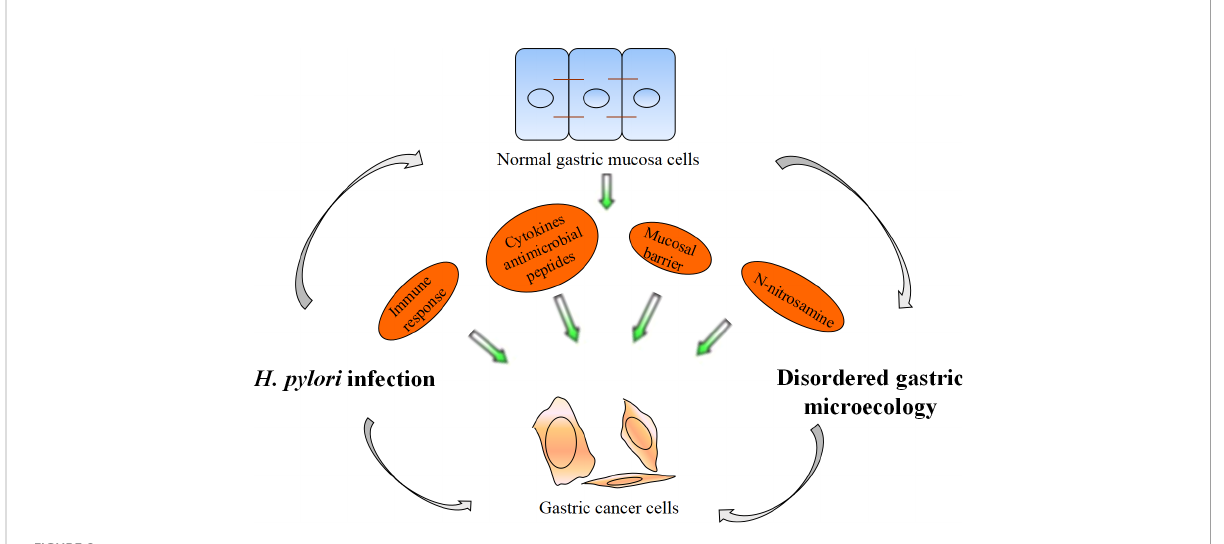
FIGURE 2 H. pylori infection promotes the occurrence of gastric cancer by regulating gastric fl